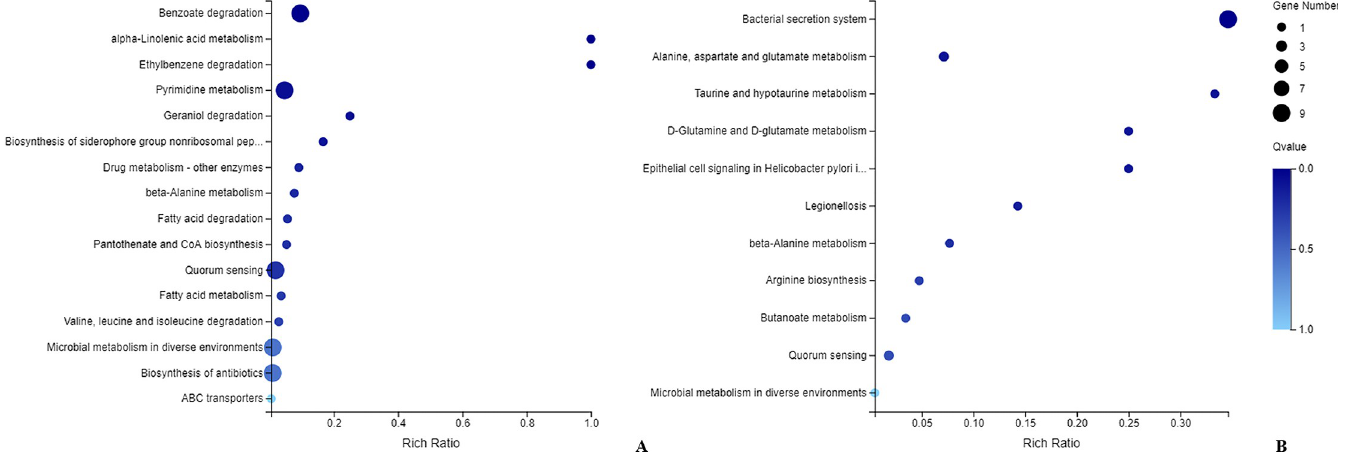
Fig 4. KEGG distribution pattern of differentially expressed genes. (A) shows the distribution of upregulated genes, and (B) shows the downregulated genes. The ordinate denotes the pathway name, the abscissa denotes the rich factor, the size of the dot indicates the number of differentially expressed genes in this pathway, and the color of the dot corresponds to different Q-value